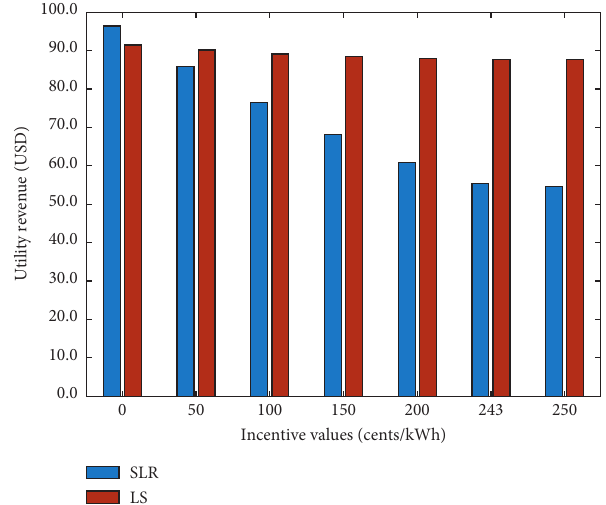
Figure 13: Utility revenue after implementation of LS and SLR DSM